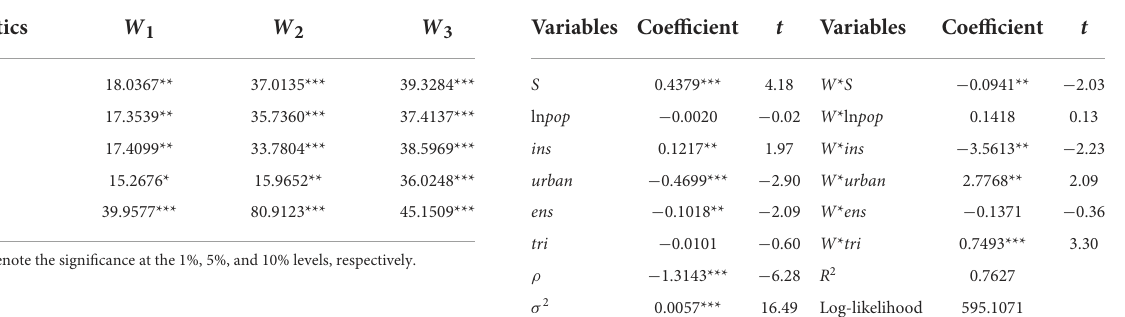
TABLE 7 Spatial model test results. TABLE 8 Regression results of spatial Durbin